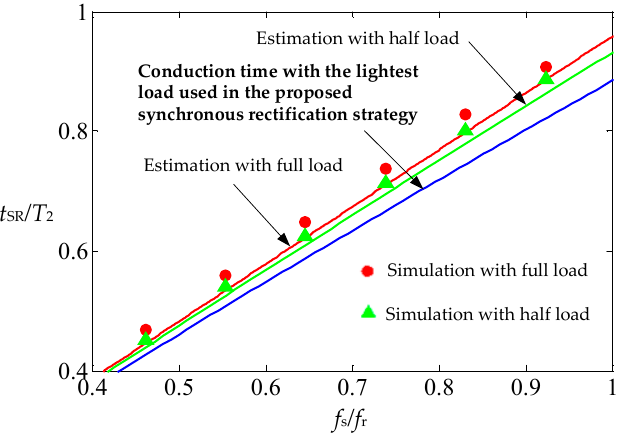
Figure 10. Normalized estimated conduction time t SR / T 2 in calculation and simulation.